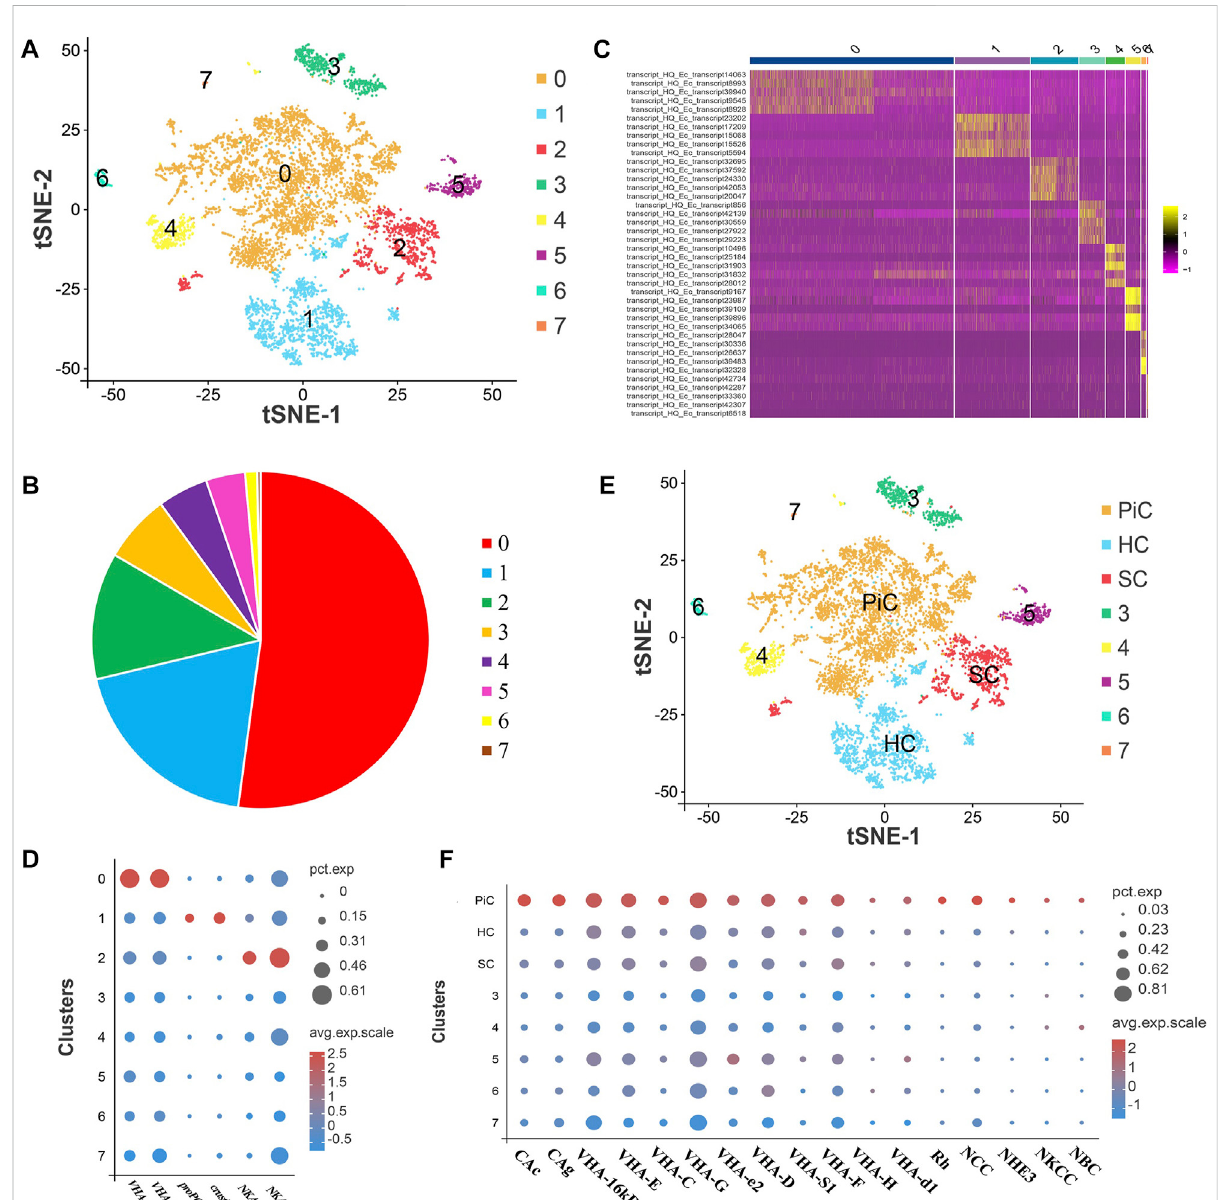
FIGURE 2 ScRNA-seqanalysisofgillcellsin E.carinicauda . (A) Thet-SNEnonlinearclusteringofgillcellsin E.carinicauda . (B) Theproportionaldistribution of each cell cluster in the total gill dataset. (C) Heatmap of the top 10 marker genes in gill cell clusters. (D) Dot plot representing the known marker genes of gill cells in clusters. (E) t-SNE visualization showing the cell names of gills. PiC pillar cells, HC hemocytes, SC septal cells. Cluster 0, 1 and 2 were identi fi ed as PiC, HC and SC, respectively. (F) Dot plot representing the distribution of ion transport related genes in clusters. CAg glycosyl-phosphatidylinositol-linked carbonic anhydrase, CAc cytoplasmic carbonic anhydrase, VHA V-type proton ATPase, Rh